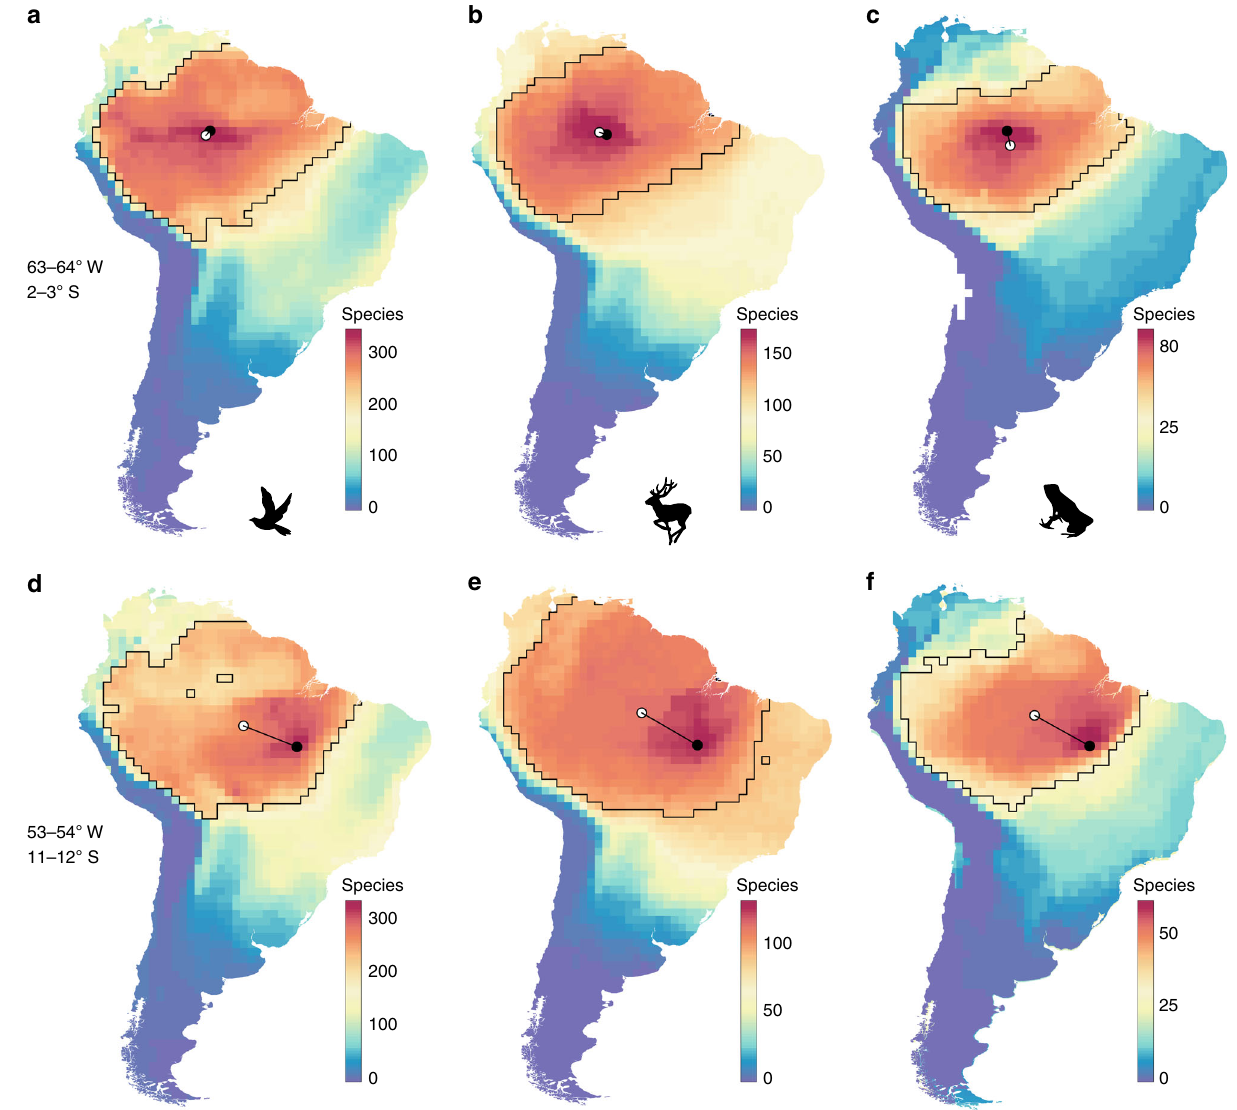
Fig. 2 Asymmetry vectors and assemblage dispersion fi elds (ADFs) for selected 1° × 1° grid cells in Amazonia. The focal cell is marked by a black point. Colors indicate the number of species shared with the focal cell. The central region (see “ Methods ” ) of the dispersion fi eld is outlined by a black line. The asymmetry vector extends from the center of the focal cell to the center of gravity (white point) of the central region. ADFs of focal cells are relatively symmetrical near the center of the Amazonian ecoregion ( a – c ) and become increasingly asymmetrical near its periphery ( d – f ), for birds ( a , d ), mammals ( b , e ), and amphibians ( c , f